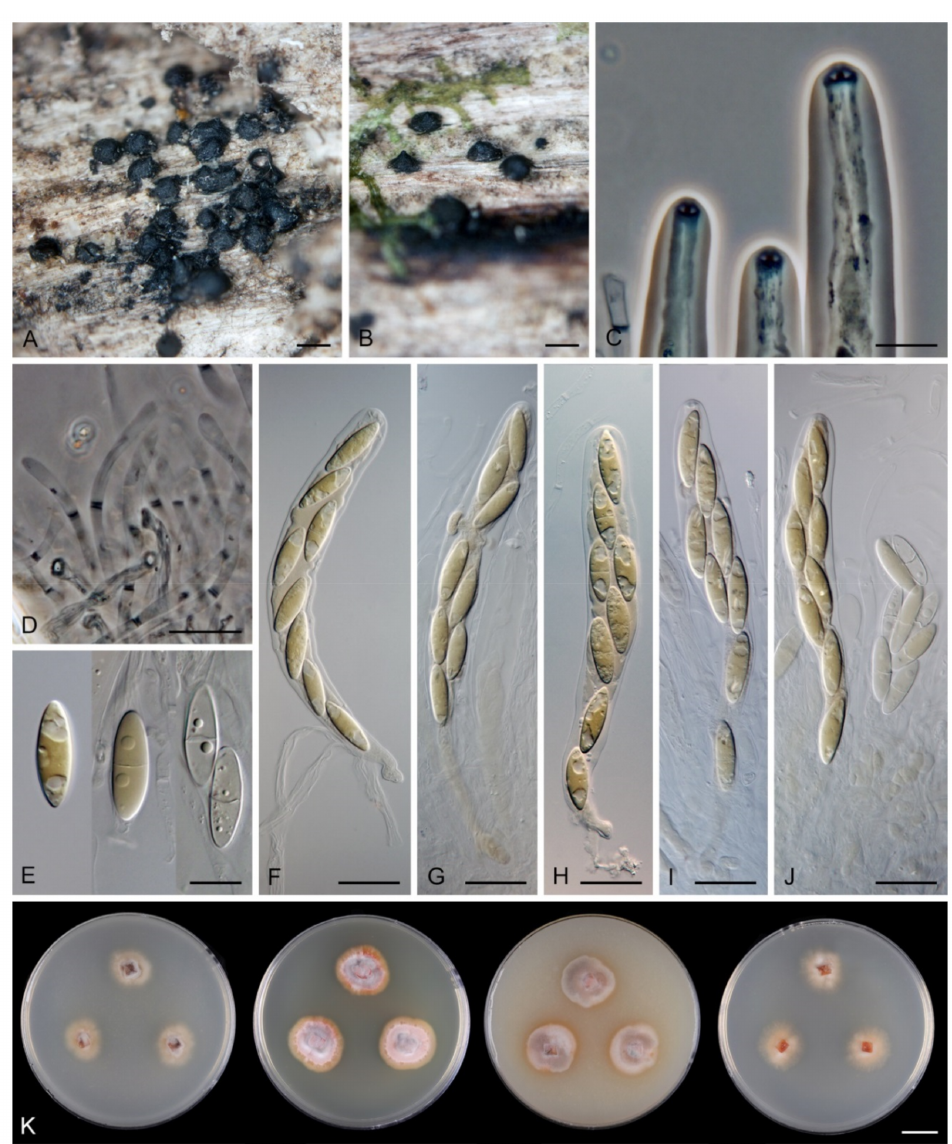
Figure 7. Flectospora sp. (ICMP 23840). ( A , B ) ascomata ( C ) ascal apices with apical rings ( D ) para- physes ( E ) ascospores ( F – J ) asci ( K ) colonies on CMD, MLA, OA and PCA after 4 weeks (from left to right). Images: ( A – J ) from nature. Scale bars: ( A , B ) 250 µ m; ( C , E ) 10 µ m; ( D , F – J ) 20 µ m; ( K ) 1